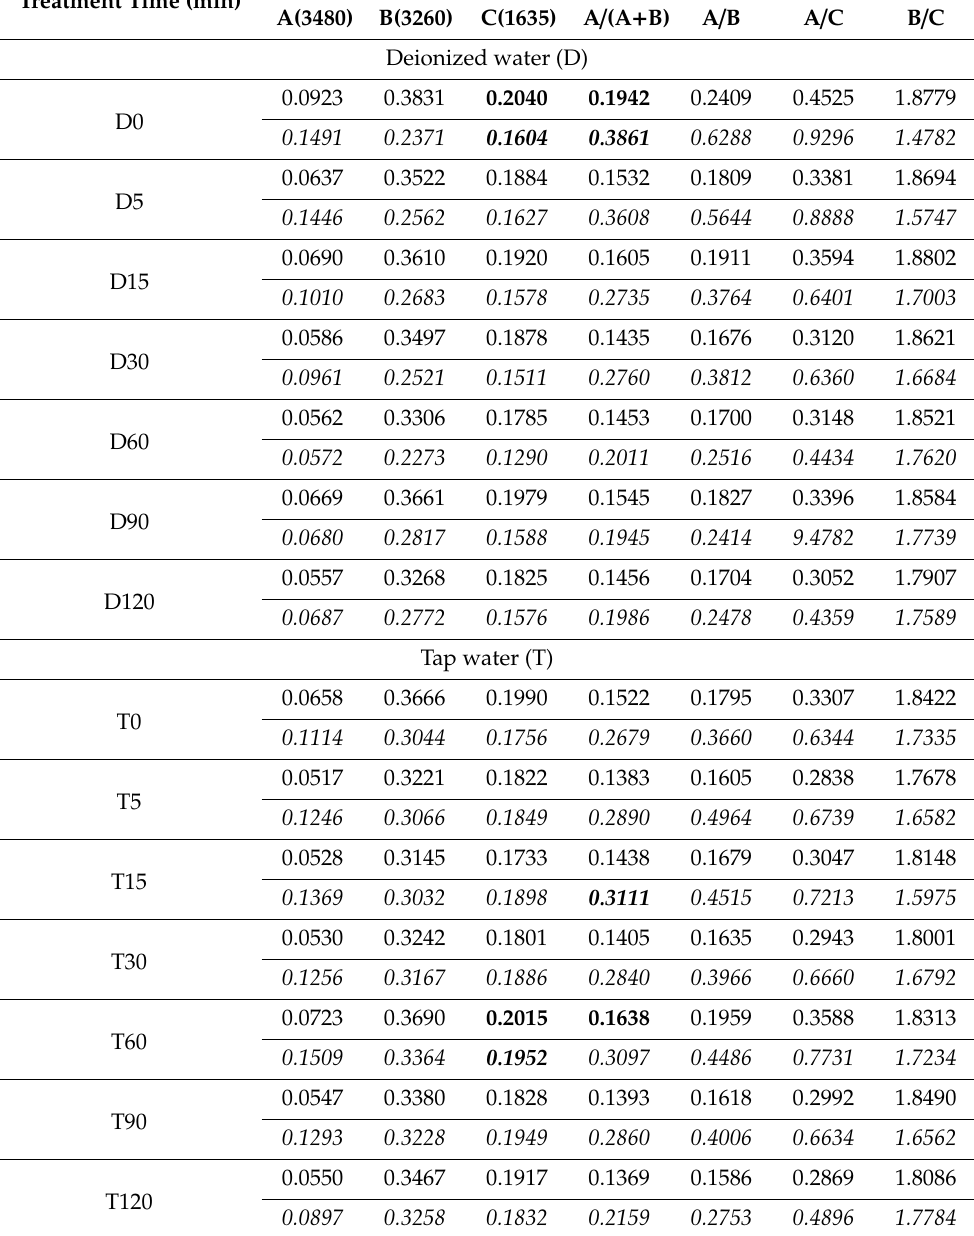
Table 7. Results of the Gaussian distribution of FTIR-ATR spectra of deionized (D) and tap (T) WST and